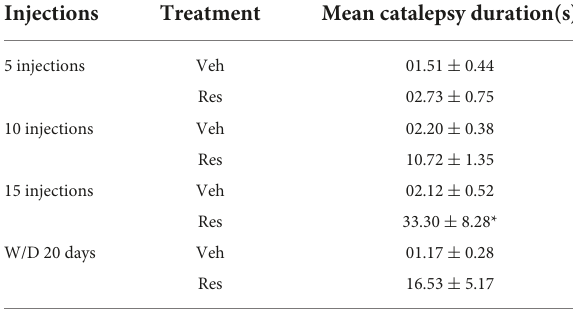
TABLE 1 Effects of repeated administration of 0.1 mg/kg reserpine (Res) or vehicle (Veh) on catalepsy test ( n = 9–10).